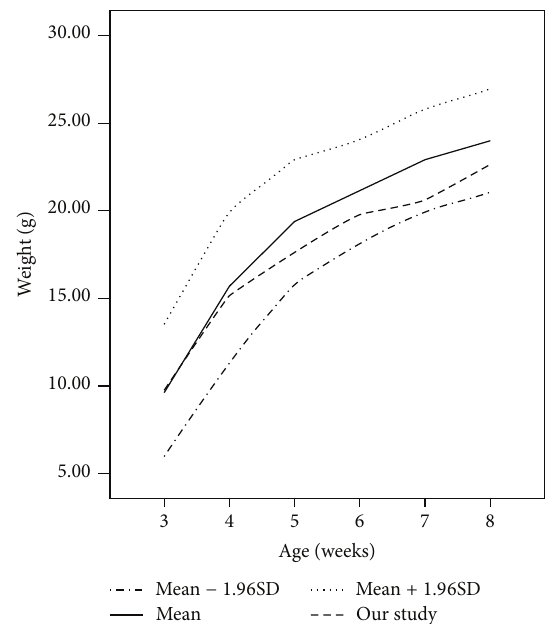
Figure 5: A body weight chart for the mice in experimental group. Reference values (mean, mean ± 1.96SD) were obtained from the JAX LAB (http://jaxmice.jax.org/support/weight/000664.html). The mean weight of mice in experimental group falls between the reference mean and mean −